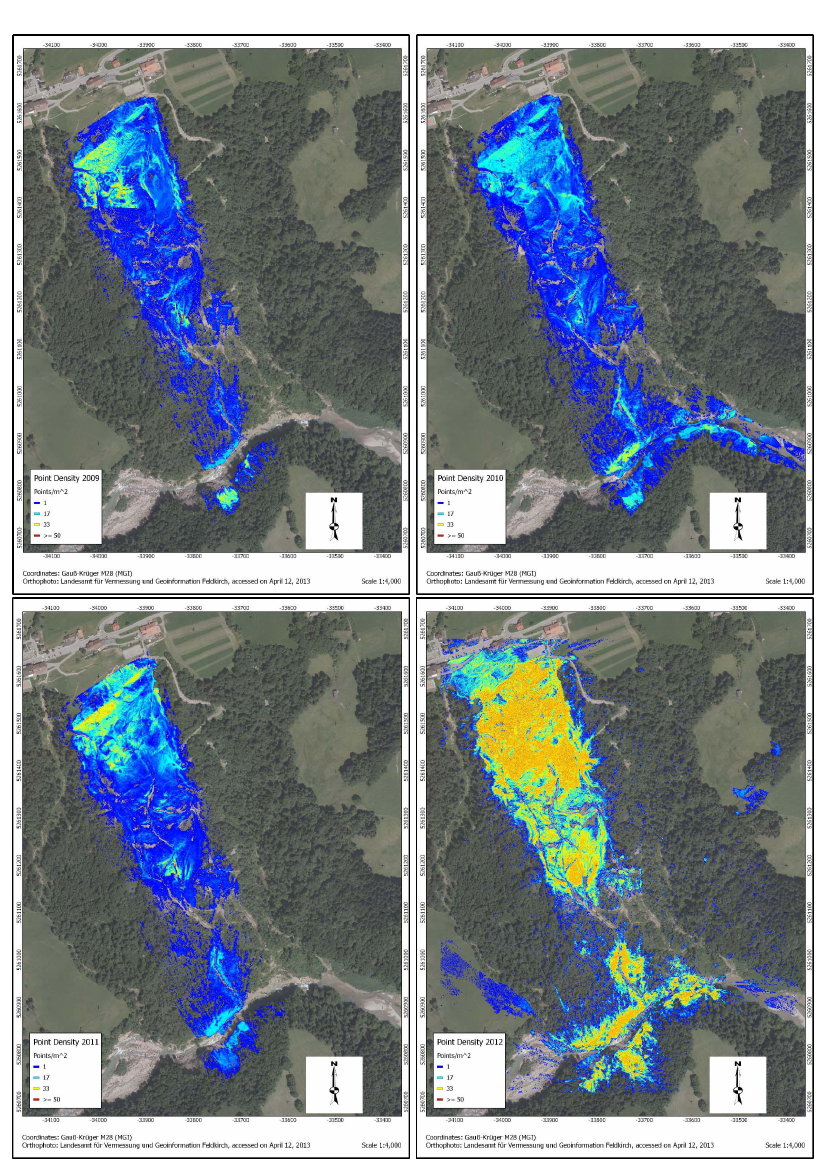
Figure 4. Point densities of the terrestrial laser scanning (TLS) campaigns from 2009 to